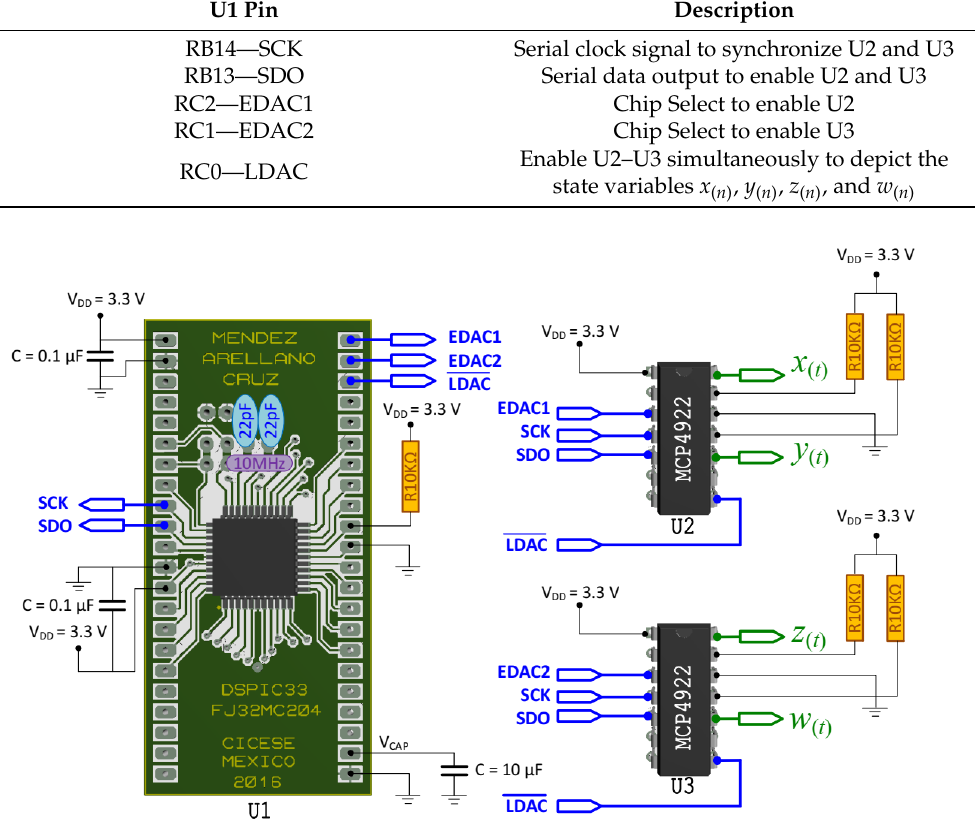
Figure 8. Schematic of the implementation of system (14) in embedded